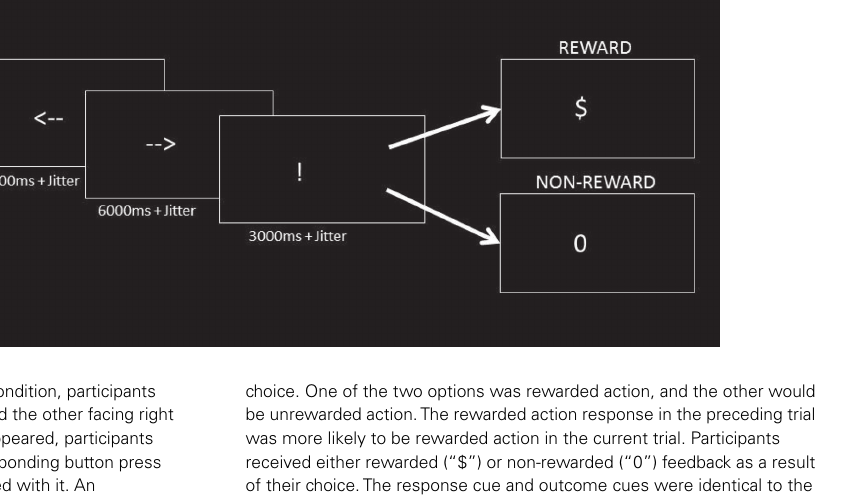
FIGURE 1 | Imagine condition. In the Imagine condition, participants saw a sequence of two arrows, one facing left and the other facing right (order randomized across trials). As each arrow appeared, participants were instructed to imagine performing the corresponding button press response (left or right) and the outcome associated with it. An exclamation mark (“!”) cued the subjects to make a response of their